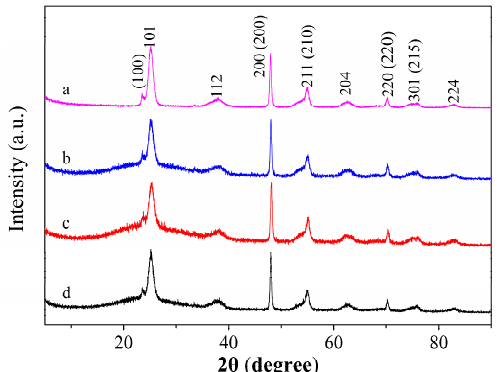
Figure 2. XRD pattern of TiO 2 nanospheres before ( a ) and after modifying Aphen with Aphen/ TiO 2 ratio of 1:50 ( b ); 1:100 ( c ) and 1:200 ( d